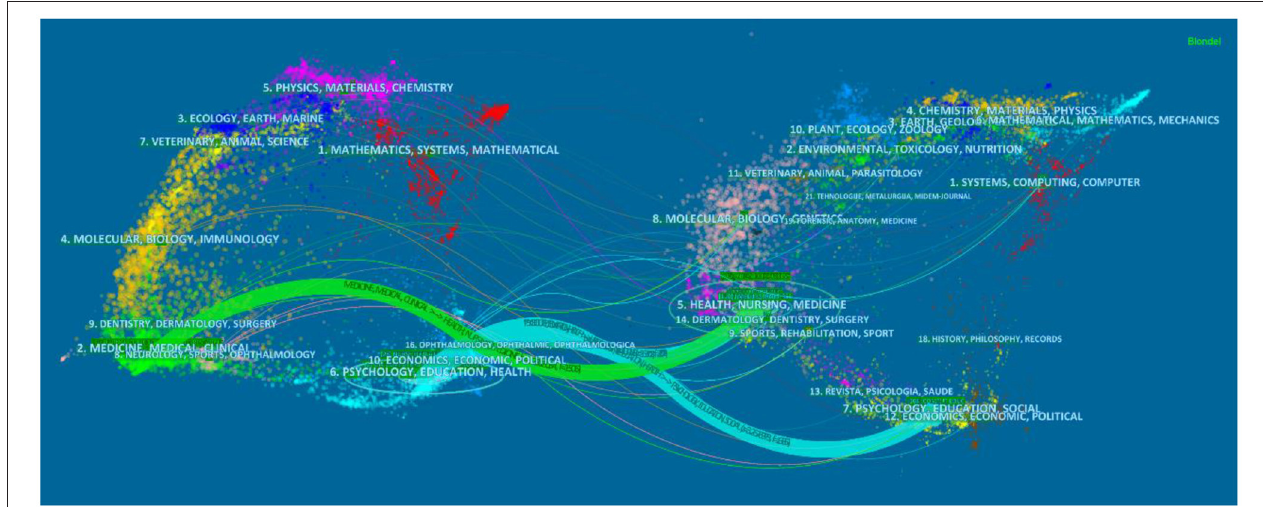
FIGURE 6 | The dual map overlay of journals contributed to publications on the application of VR in Nursing from 2012 to 2021. The green path shows articles in the research fields of MEDICINE / MEDICAL / CLINICAL that are more likely to cite articles in the field of HEALTH / NURSING / MEDICINE. The blue path shows the subject fields of PSYCHOLOGY / EDUCATION / SOCIAL, which are probably cited by PSYCHOLOGY / EDUCATION / HEALTH.